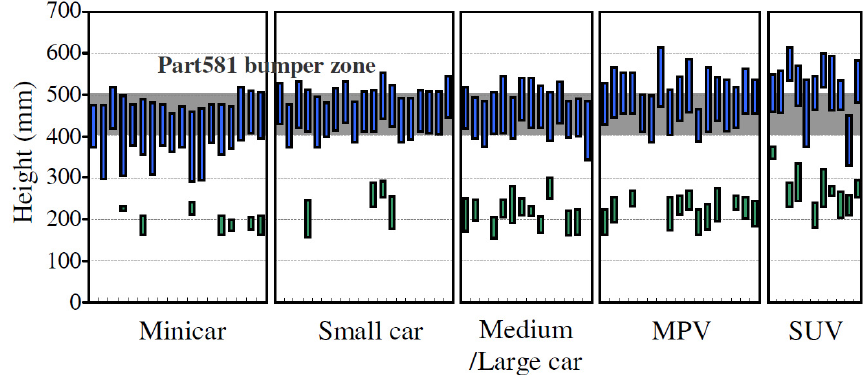
Figure 7. The ground clearance of front rails (blue bars) and subframes (green bars).